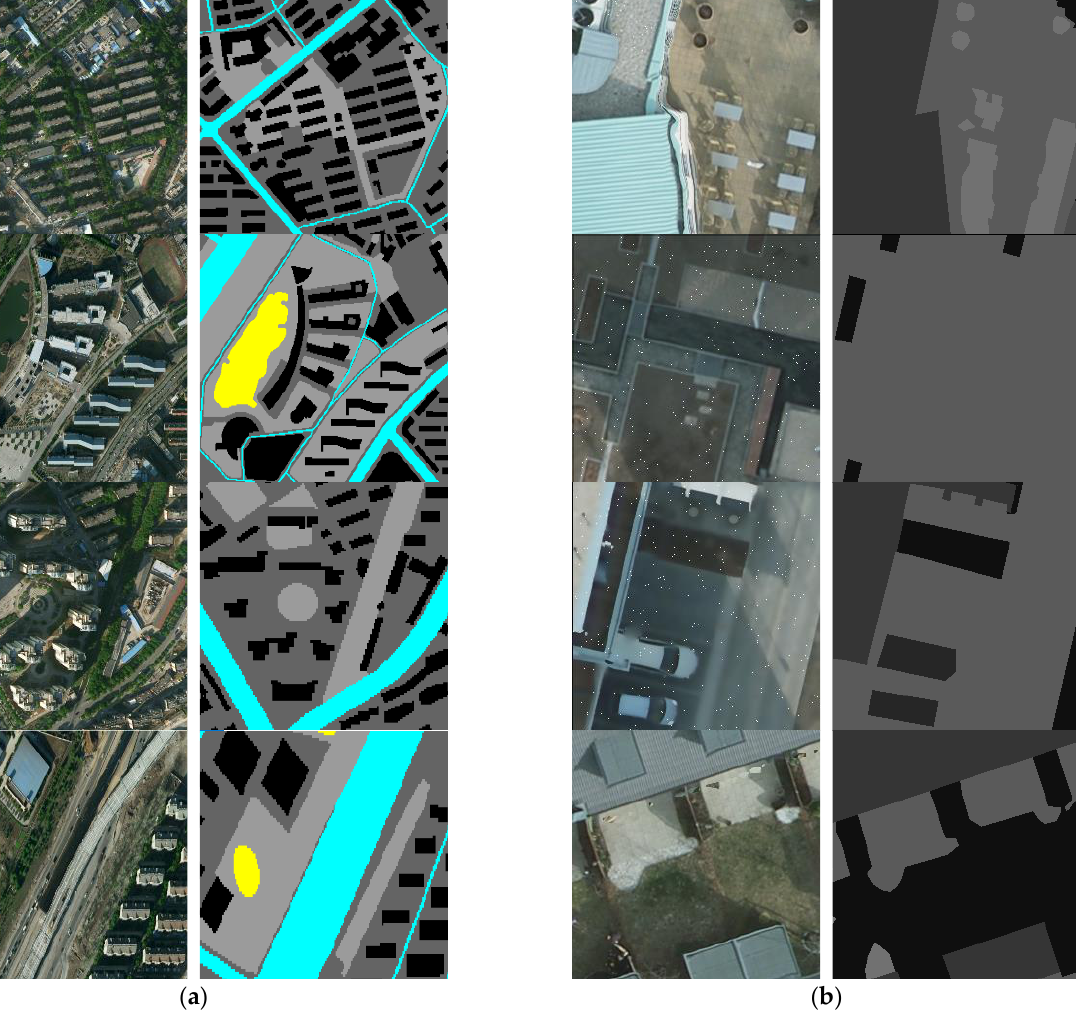
Figure 11. Representative samples of each category in the dataset after data enhancement of the original images are shown on the left and ground truth on the right: ( a ) the BDCI 2017 dataset and ( b ) the ISPRS Potsdam dataset.